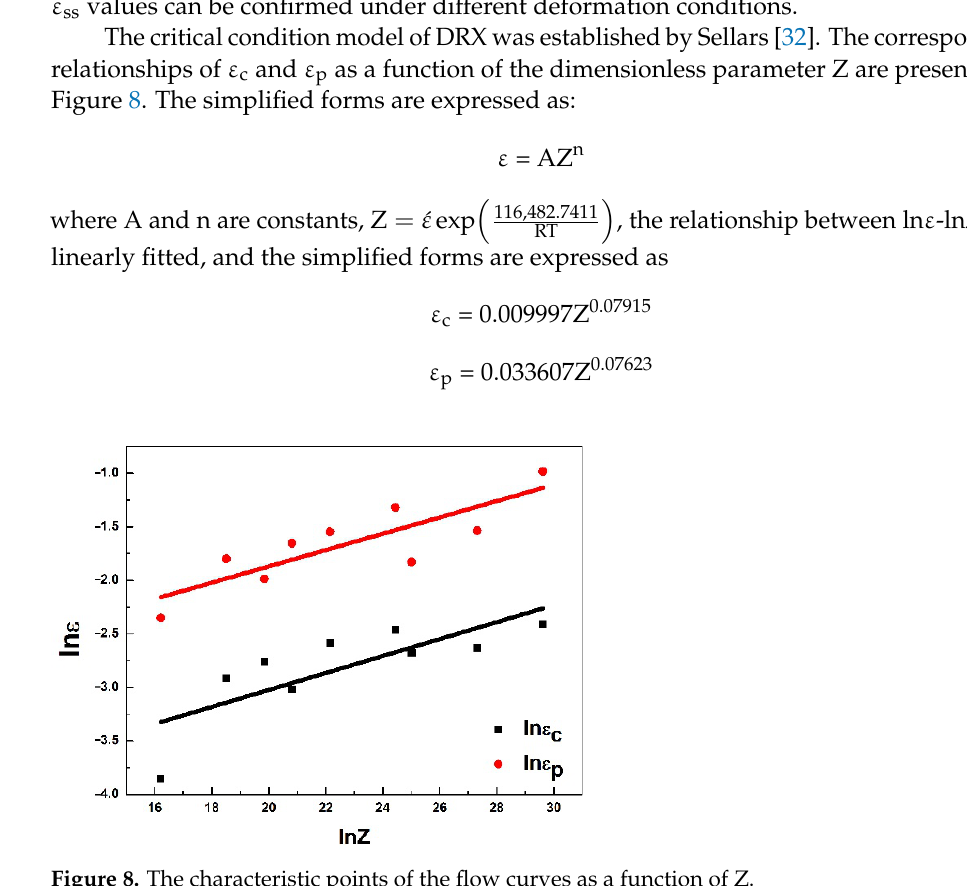
Figure 7. Typical θ – σ plot obtained by deforming at the temperature of 300 °C and the strain rate of 0.01 s − 1 .